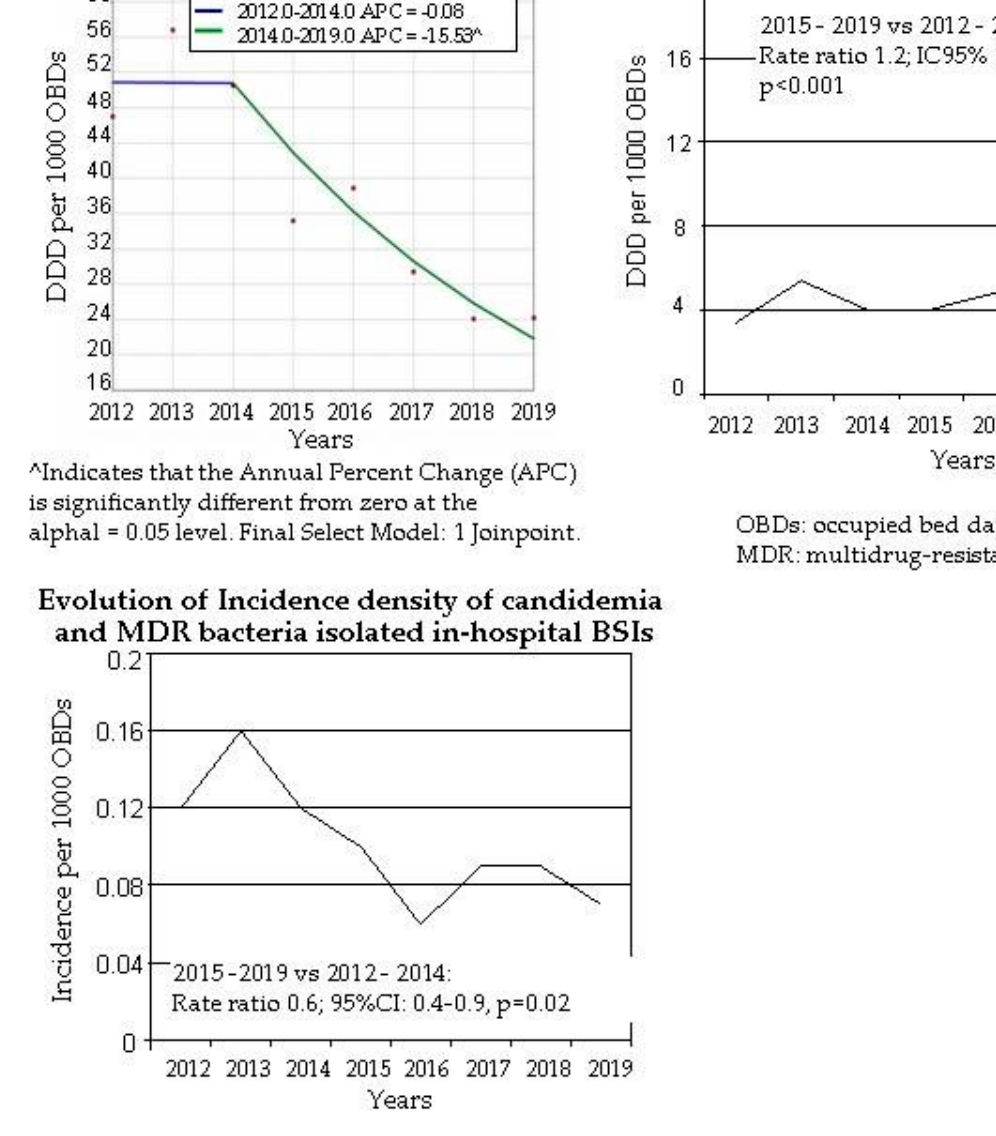
Figure 1. Evolution of carbapenems consumption and incidence of candidemia and MDR bacteria isolated in-hospital bloodstream infections (BSIs).